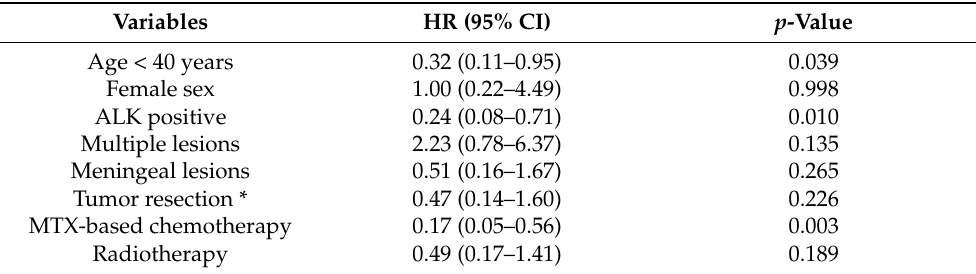
Table 3. Factors related to prognosis for primary anaplastic large cell lymphoma of the central nervous system.